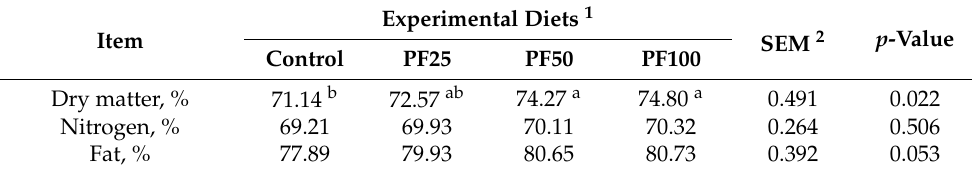
Table 4. Effect of replacing soybean oil with poultry fat on nutrient digestibility of broilers.